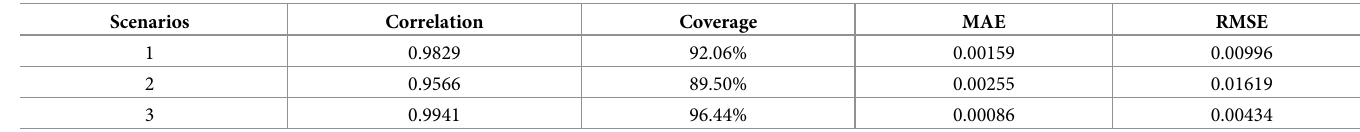
Table 1. Performance comparison of the ST-PCLM approach in three different types of scenarios of simulation study 1. Correlation coefficient average (avg) of the 100 replicates, average coverage % and mean absolute errors (MAE) and root mean squared error (RMSE) are also shown. Scenarios